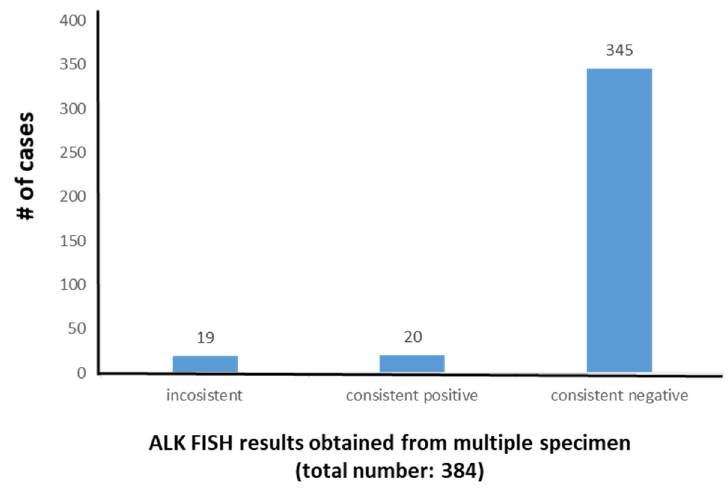
Figure 1. ALK FISH results of multiple specimens collected at di ff erent time points in 384 lung cancer patients.